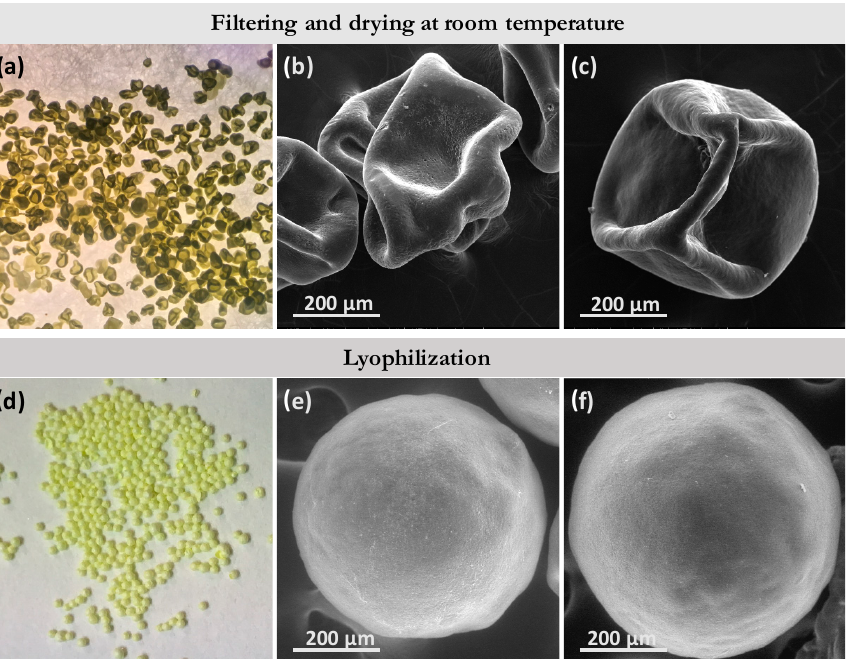
Figure 6. Drying of the enteric microparticles synthesized in the coaxial microfluidic system, Q i /Q m /Q o = 5/10/200 μ L/min. ( a ) Optical microscopy image of the 2% Eudragit ® microparticles after filtering and drying at room temperature. SEM images of the microparticles synthesized with ( b ) 2% and ( c ) 4% Eudragit ® after filtering and drying at room temperature. ( d ) Optical microscopy image of the 2% Eudragit ® microparticles after the lyophilization process. SEM images of the microparticles synthesized with ( e ) 2% and ( f ) 4% Eudragit ® after the lyophilization process.